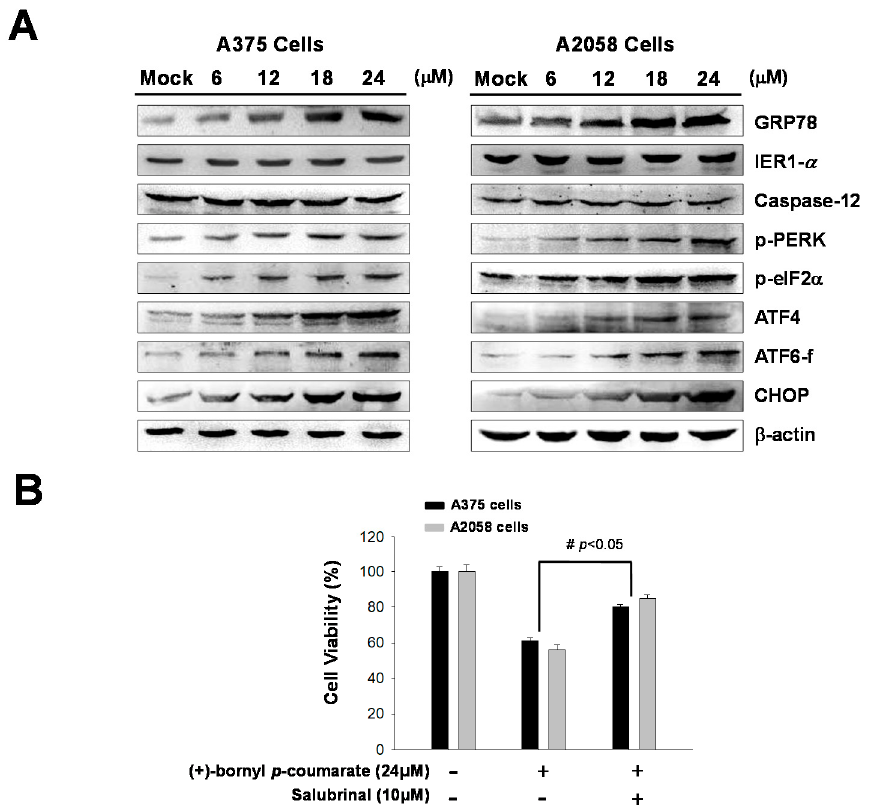
Analysis of the e ff ects of ( + )-bornyl p -coumarate on endoplasmic reticulum (ER) stress-associated proteins in A375 and A2058 cell lines. ( A ) Changes in ER stress response-related proteins in A2058 and A375 melanoma cells after ( + )-bornyl p -coumarate treatment were evaluated by western blotting. ( B ) Incubation of cells with salubrinal demonstrated that the apoptosis caused by ( + )-bornyl p -coumarate is mediated by the PERK–eIF2 α –ATF4–CHOP pathway. Data are presented as the means ± SD of at least three independent experiments. The results were analyzed using Student’s t -test ( # p < 0.05, compared with ( + )-bornyl p -coumarate treatment groups). Mock: cells treated with vehicle control (DMSO).